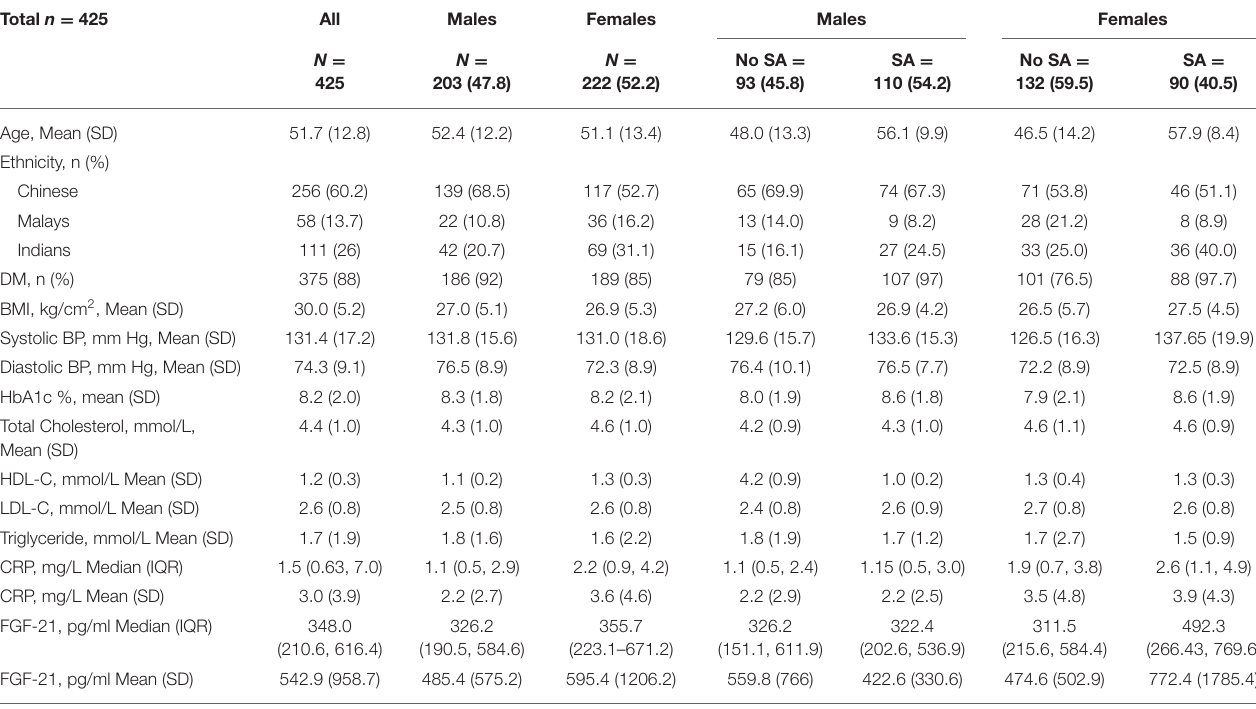
TABLE 1 | Baseline characteristics of the